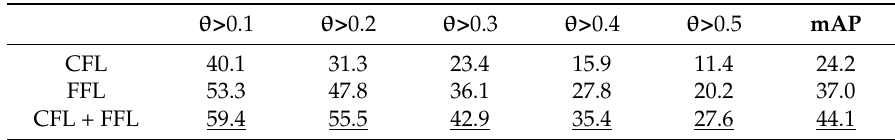
Table 2. Comparison of spatio-temporal action-detection performances (video-mAP) with the feature combinations on LIRIS-HARL dataset.